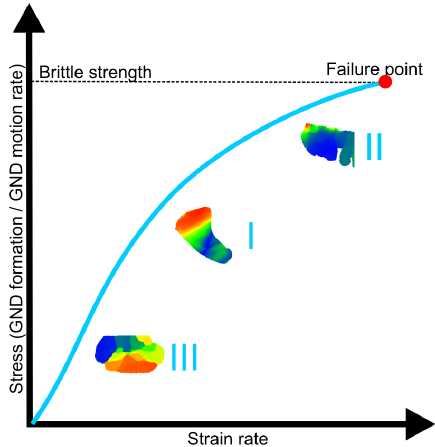
Figure 15. Schematic diagram for different finite crystal-plastic de- formation patterns in zircon that are stress-strain rate dependent. I–III reflect deformation pattern types (I), (II) and (III), respectively. GND: geometrically necessary